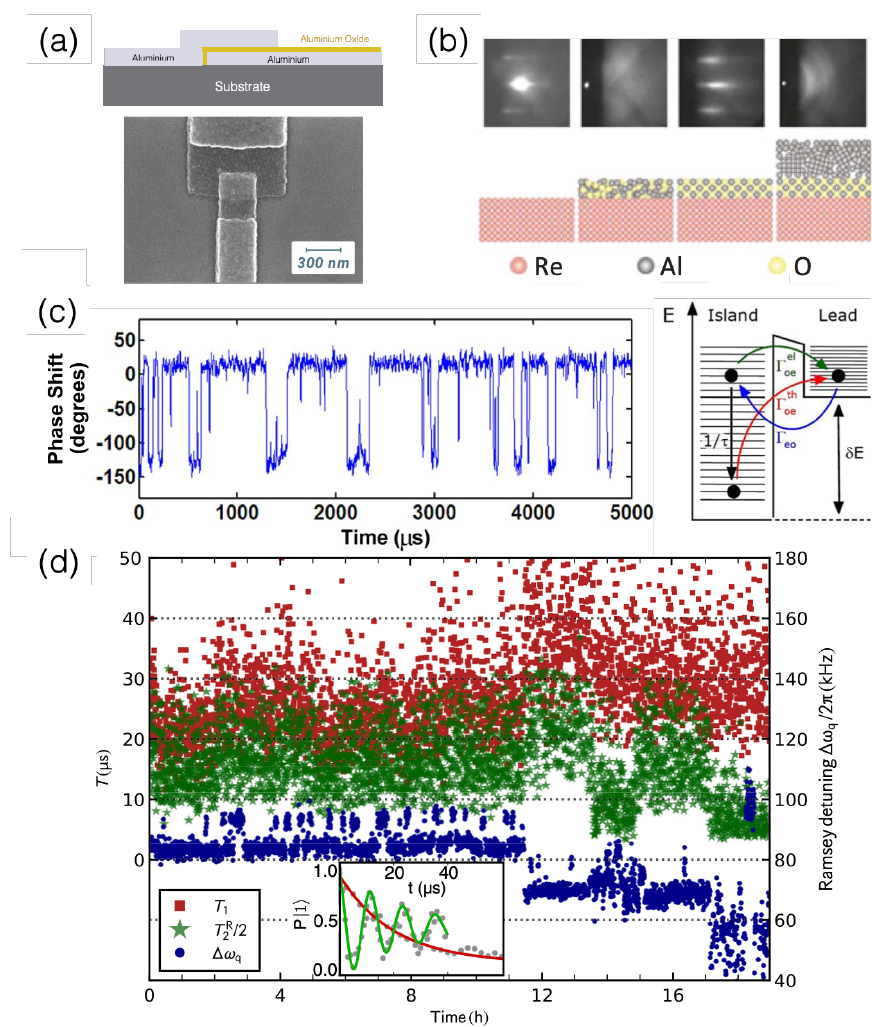
Figure 4. ( a ) A cross-section (top) and a scanning electron microscope (SEM) image (bottom) of a simple Josephson junction (JJ) based on aluminum material. Images from https://angstromengineering.com/ josephson-junction-thin-film-deposition-superconducting-circuits/, accessed on 20 August 2022 (public domain). ( b ) RHEED images (top) at the material growth sequences to form a single-crystal Al 2 O 3 tunnel barrier during an epitaxial growth on epitaxial rhenium (Re) layer, adapted with per- mission from Ref. [98]; ©2006 American Physical Society. ( c ) Random telegraph signals (left) and a diagram of quasiparticle tunneling in a charge qubit, where Γ eo is the tunneling rate from a lead to the island; the tunneling rate from the island to the lead by thermal excitation and by elastic interaction between quasi-particles are denoted as Γ el oe and Γ th oe , respectively (right). The images are adapted with permission from Ref. [46]; ©2008 American Physical Society. ( d ) Time traces of JJ parameters in a transmon qubit. T 1 and T 2 are taken from the Ramsey detuning fit in frequency change ∆ ω q with the probability of the excited state population presented in the inset adapted with permission fromRef. [99]; ©2019 American Physical